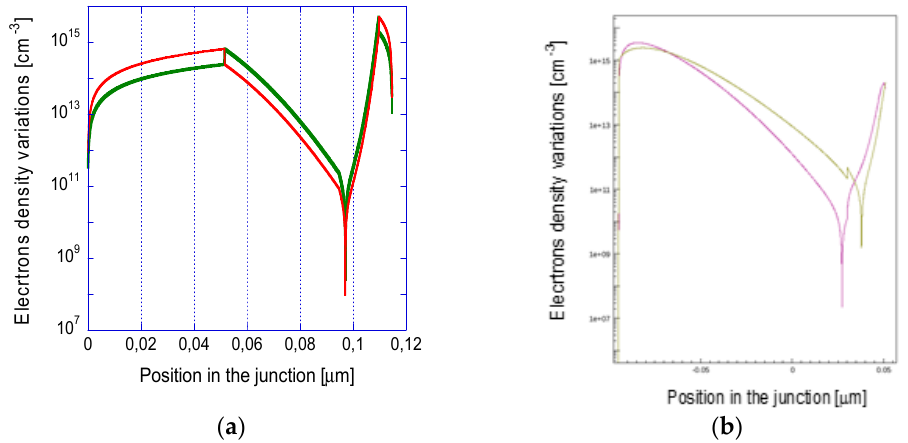
Figure 3. Distribution of real (red lines) and imaginary (green lines) parts of variations of electron density at 1 THz, ( a ) as obtained from the two solutions n(cid:3548) (cid:2885) and n(cid:3548) (cid:2886) , and ( b ) from TCAD simulations.